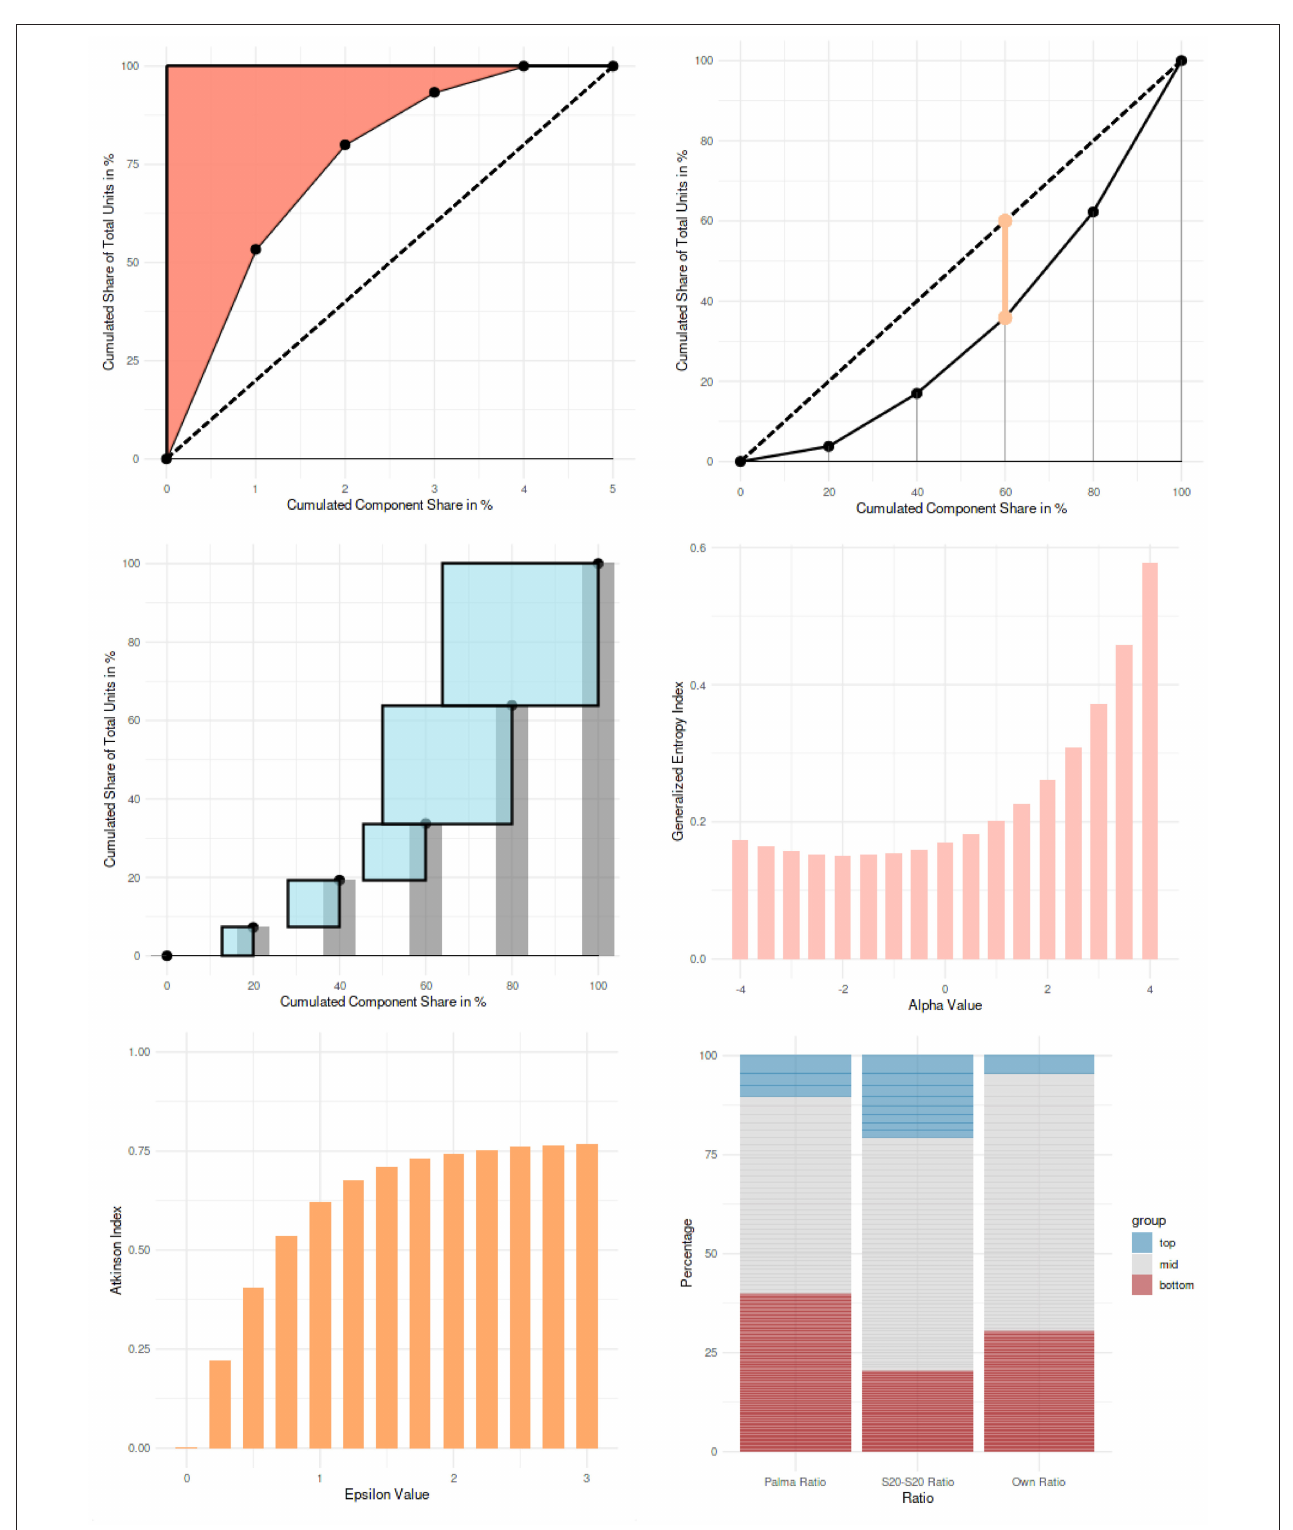
FIGURE 2 | Example visualizations from the interactive web application (from left to right and from top to bottom): Rosenbluth index, Hoover index, Herfindahl-Hirschman index, generalized entropy index for different values of the fine-tuning parameter α , Atkinson index for different values of the fine-tuning parameter ε , and tail